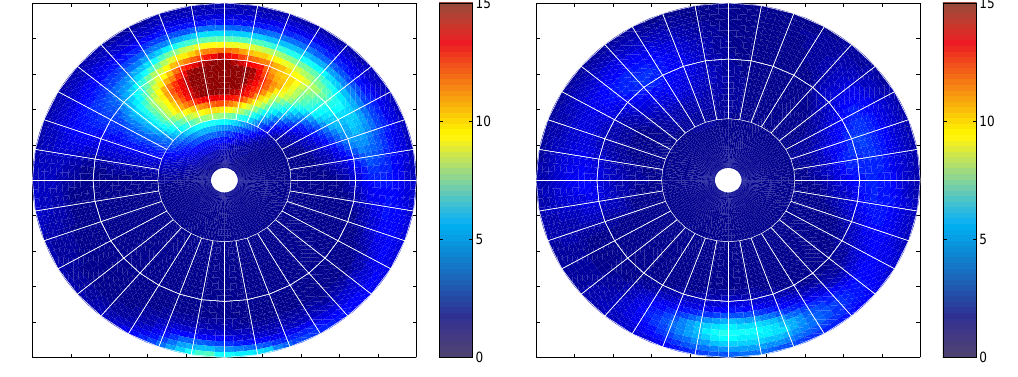
ing is different. Before the substorm onset (05:00 UT in the simulation) a small amount of Joule heating is concentrated mainly in the nightside oval. At 05:30 UT, after the onset, the Joule heating power rate is enhanced in the nightside oval, and there is a small maximum in the duskside oval. Half an